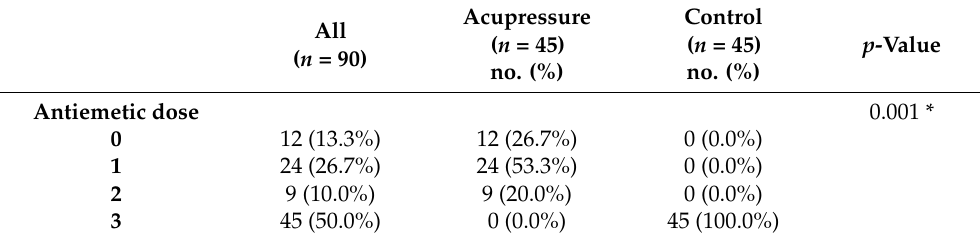
Table 5. Frequency of antiemetic requirement in 24 h. * indicates statistically significant; p < 0.05. All ( n =